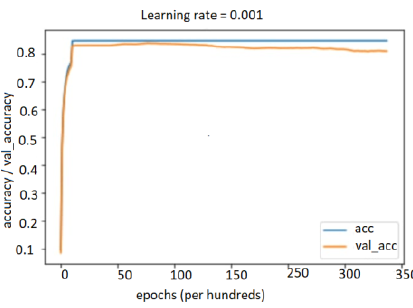
Figure 14. Training accuracy/validation accuracy versus epochs for audio modality.